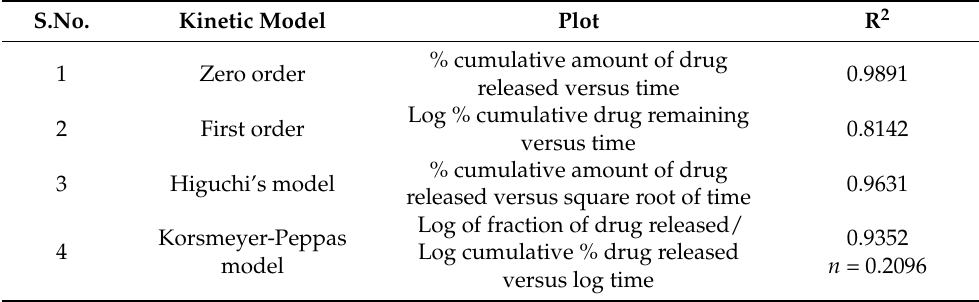
Table 6. Release kinetic model applied to evaluate the best-fitted model for S-PE-SNEDDS (SOF3).